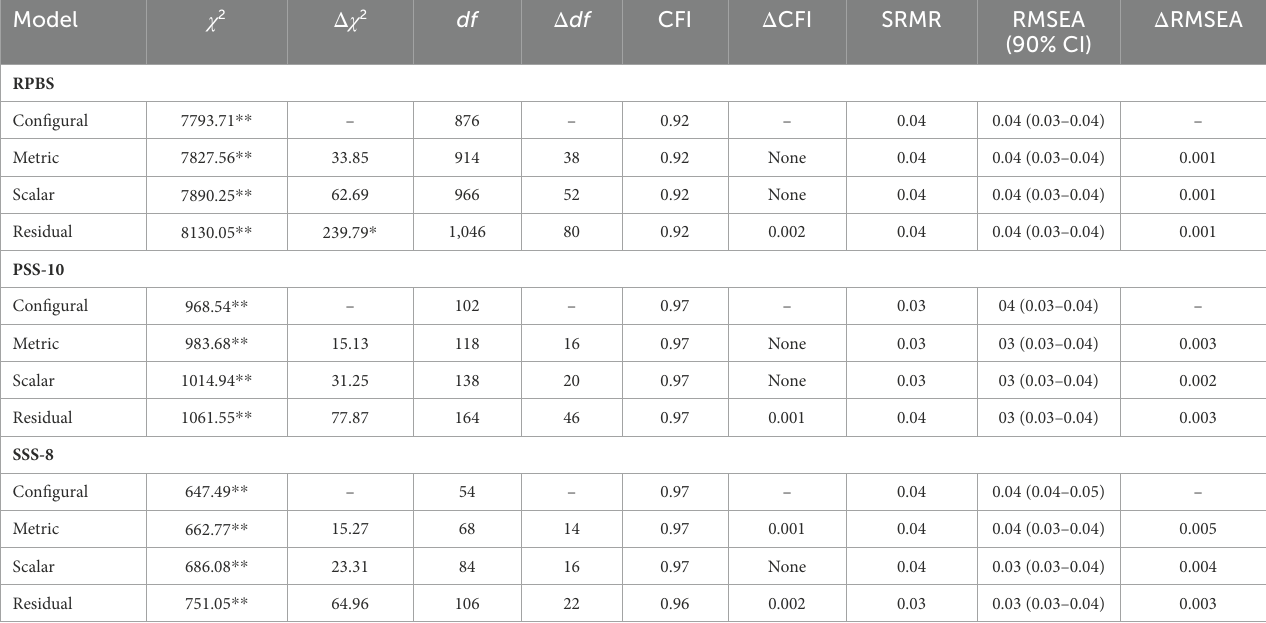
TABLE 2 Fit indices for longitudinal invariance models. Model